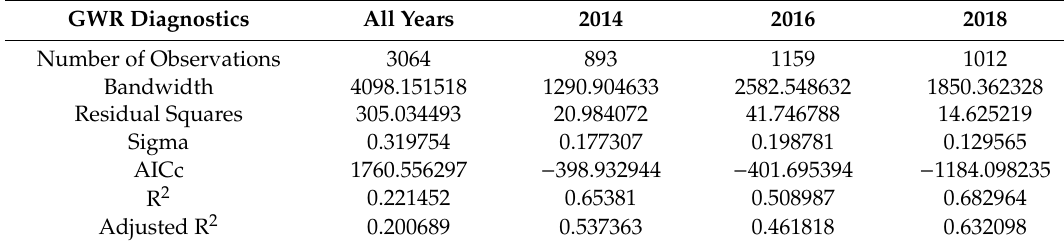
Table 6. Comparison of GWR models.